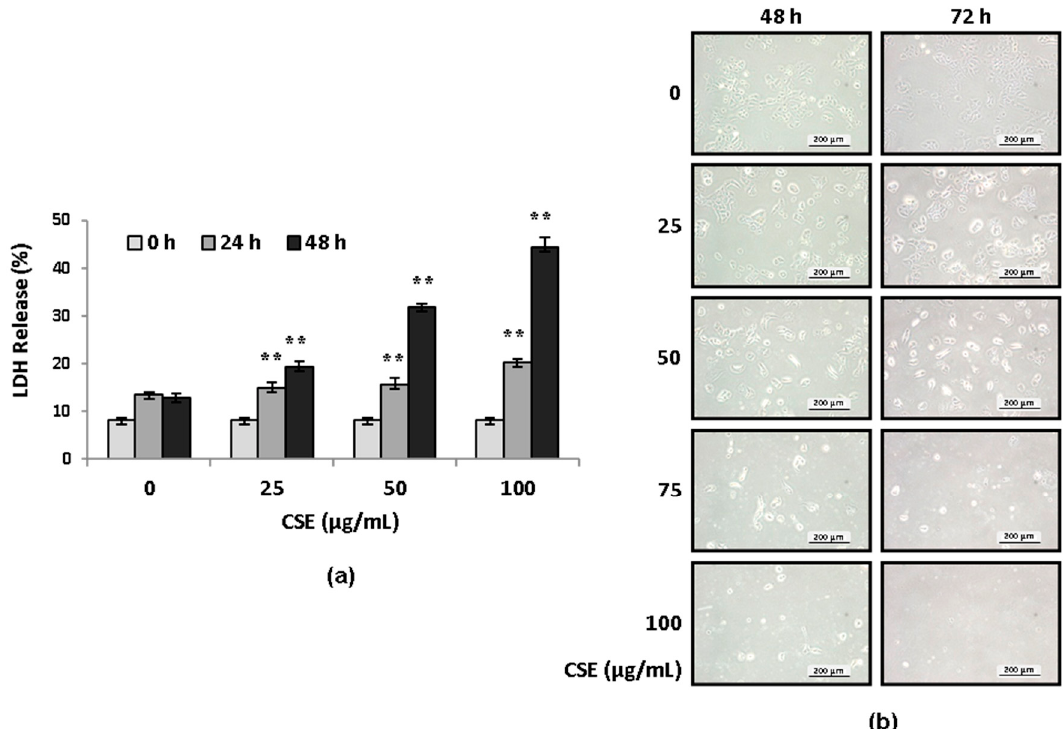
Figure 1. Cytotoxicity induced by CSE in A549 cells. ( a ) A549 cells were treated with 25–100 µ g/mL CSE for 24 or 48 h, and cytotoxicity was measured by LDH release from cells. The readings were normalized to the maximum LDH activity in cells and medium. ** p < 0.01, compared to untreated cells. N = 4. ( b ) Images of A549 cells showing cell death after exposure to CSE for 48 or 72 h. CSE, cigarette smoke extract; LDH, lactose dehydrogenase.